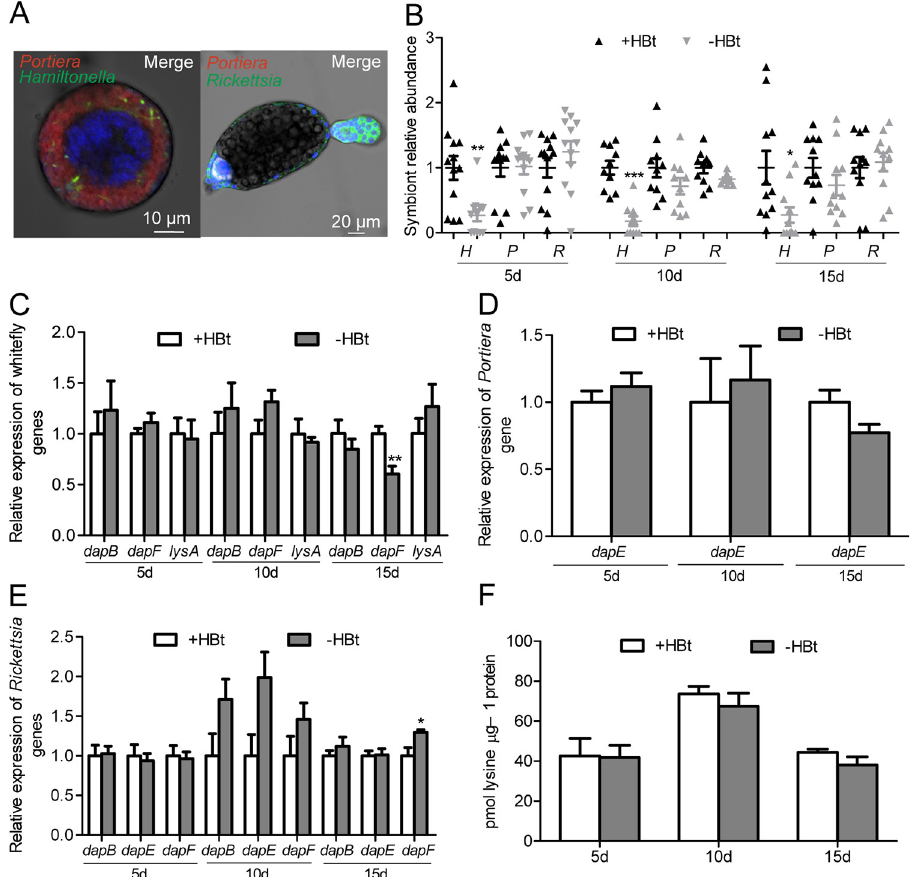
Fig 2. Effects of Hamiltonella deficiency on lysine gene expression and lysine levels in B . tabaci . (A) Localization of symbiotic bacteria Portiera (red) and Hamiltonella (green) in the whitefly bacteriocyte, as well as Portiera (red) and Rickettsia (green) in the whitefly ovary. n = 3. (B) Effects of antibiotic treatments on the abundance of symbionts in B . tabaci at 5 d, 10 d, and 15 d after emergence. H , P and R represent Hamiltonella , Portiera and Rickettsia , respectively. n = 12, 10 and 11 for 5 d, 10 d, and 15 d, respectively. (C) Effects of Hamiltonella deficiency on expression of whitefly lysine genes in B . tabaci at 5 d, 10 d, and 15 d after emergence. n = 4. (D) Effects of Hamiltonella deficiency on expression of Portiera lysine gene in B . tabaci at 5 d, 10 d, and 15 d after emergence. n = 4. (E) Effects of Hamiltonella deficiency on expression of Rickettsia lysine genes in B . tabaci at 5 d, 10 d, and 15 d after emergence. n = 4. (F) Effects of Hamiltonella deficiency on lysine levels in B . tabaci at 5 d, 10 d, and 15 d after emergence. n = 6. +HBt and -HBt represent Hamiltonella -infected and Hamiltonella -cured whiteflies, respectively. Data are means ± SEM. The significant differences between treatments are indicated by asterisks ( � P < 0.05; �� P < 0.01; ��� P < 0.001).